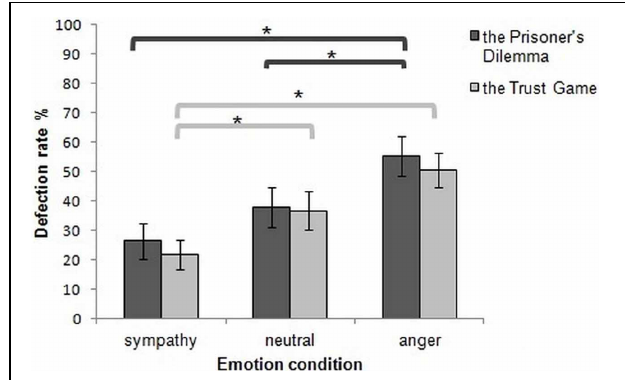
FIGURE 4 | Mean percentage defection rates in both the Prisoner’s Dilemma and the Trust Game depended upon emotion condition. The asterisks highlight significant paired comparisons after Bonferroni correction ( p ≤ 0 . 017). Error bars represent ± 1 SEM.